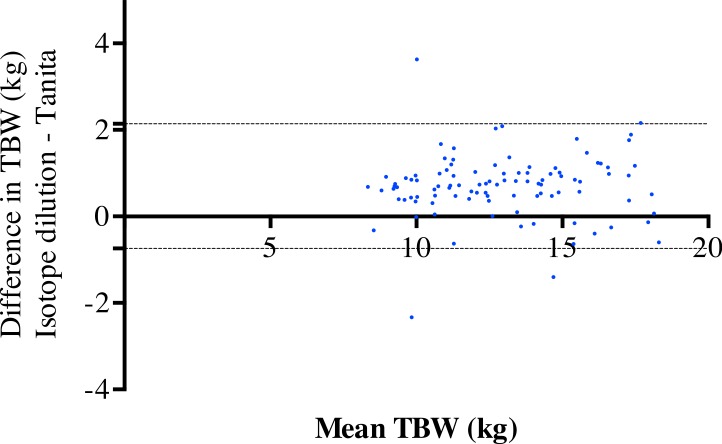
Comparison of isotope dilution and Tanita system.Bland–Altman plots showing the level of agreement for isotope dilution and the Tanita system methods for total body water.